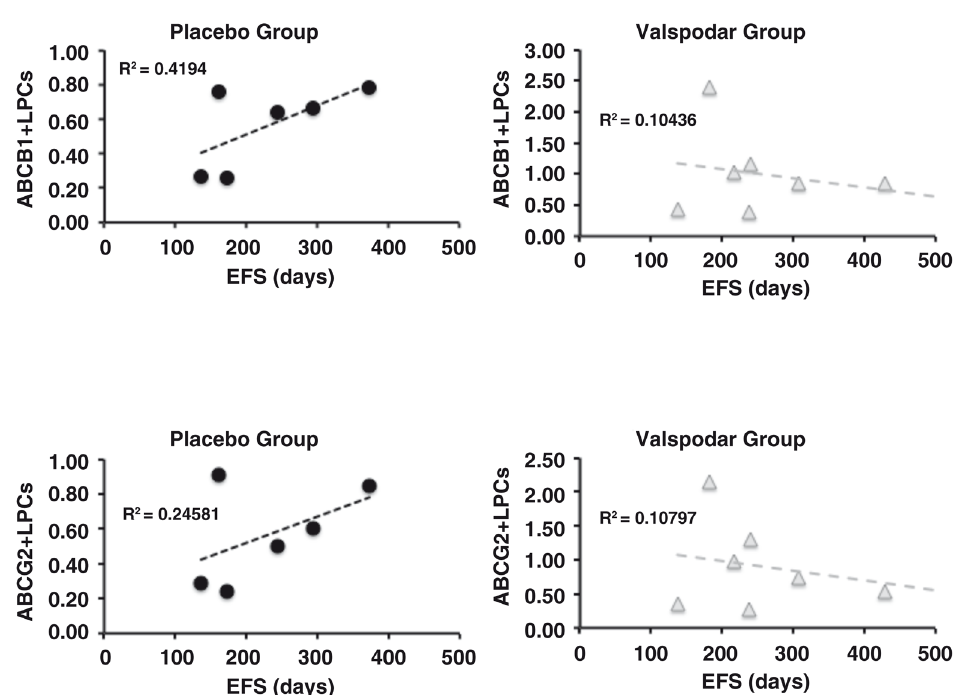
Figure 5. Event-free survival of dogs as a function of ABCB1 and ABCG2 expression in lymph node LPCs from dogs with large B-cell lymphoma at diagnosis. Dot plots showing the relationship between ABCB1 expression and event-free survival (EFS) in days (top) and between ABCG2 expression and EFS in days (bottom) in dogs treated with placebo (N = 9) or with neoadjuvant valspodar (N = 9) where samples were available for these measurements. The dashed lines represent linear regressions and their R 2 values are indicated on each graph. The Y-axis represents the % of ABC + /Progenitor + lymph node B cells. Data were analyzed and graphs were assembled using MS Excel.